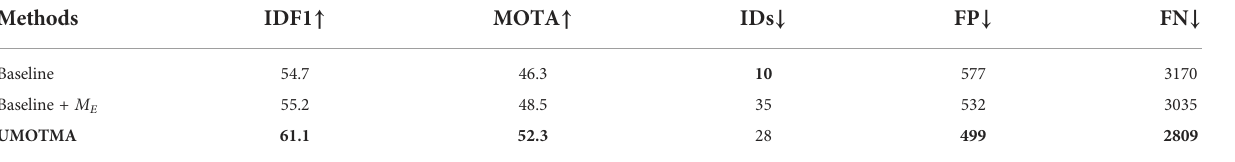
TABLE 3 Ablation study on UMOT